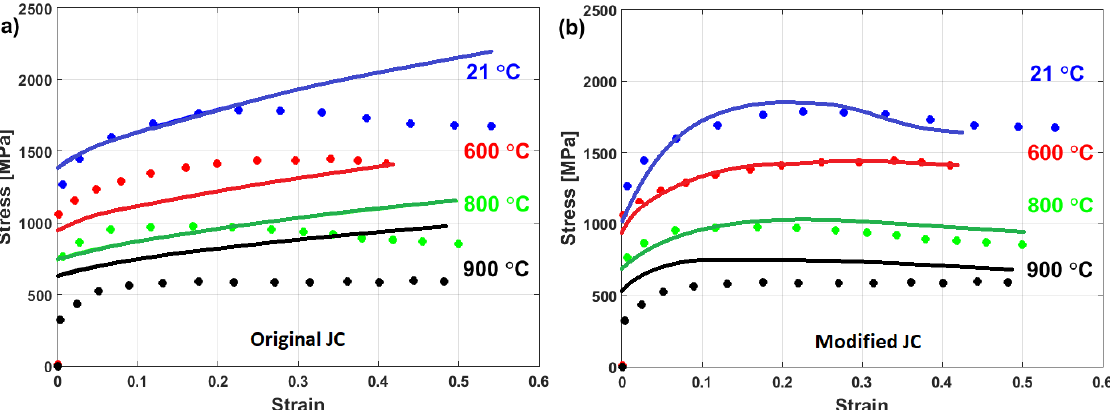
Figure 36. Comparison between experimental stresses (solid lines) and predicted stresses (dashed lines) for Inconel 718 superalloy obtained by ( a ) the original JC model and ( b ) the modified JC model that was introduced by Iturbe et al. [49].